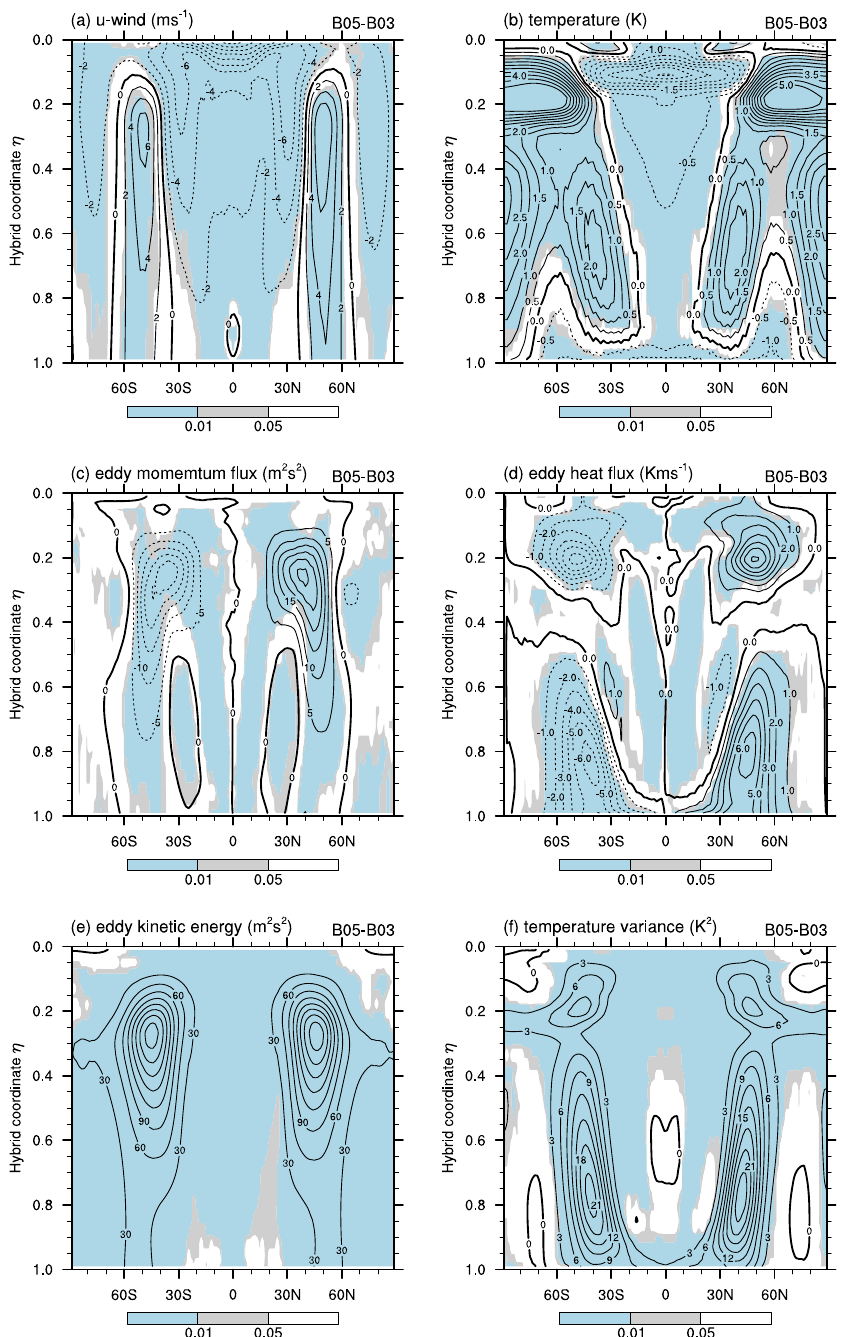
Fig. 12. Differences between the ensemble mean climate statistics in the Held–Suarez tests performed with the ICOHDC at R2B3 and R2B5 resolutions. Dashed contours indicate negative values. In the areas with gray and light blue shading, the differences are judged to be significant in the Kolmogorov–Smirnov test at 0.05 and 0.01 significance levels, respectively. Further details can be found in Sect. 6.2.